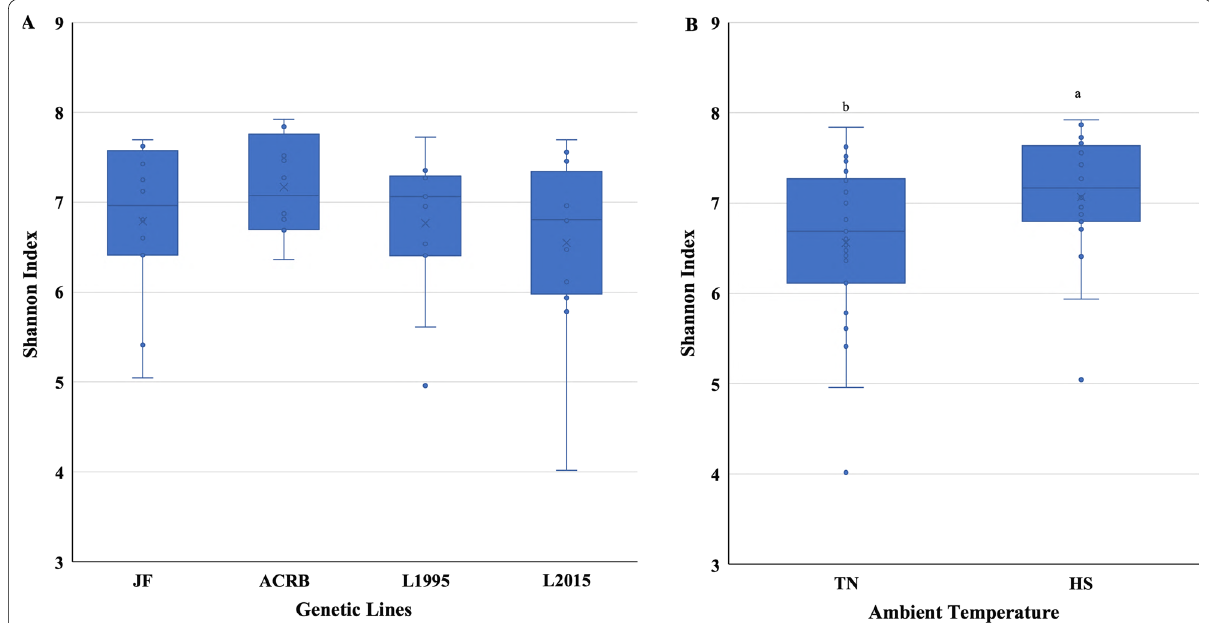
Fig. 7 Alpha diversity in the ileal mucosa of Jungle Fowl (JF), Athens Canadian Random Bred (ACRB), 1995 Random Bred (1995), and 2015 Modern Random Bred (2015) chicken lines raised under thermoneutral (TN) or heat stress (HS) condition on d 56. Shanon’s diversity index for genetic lines